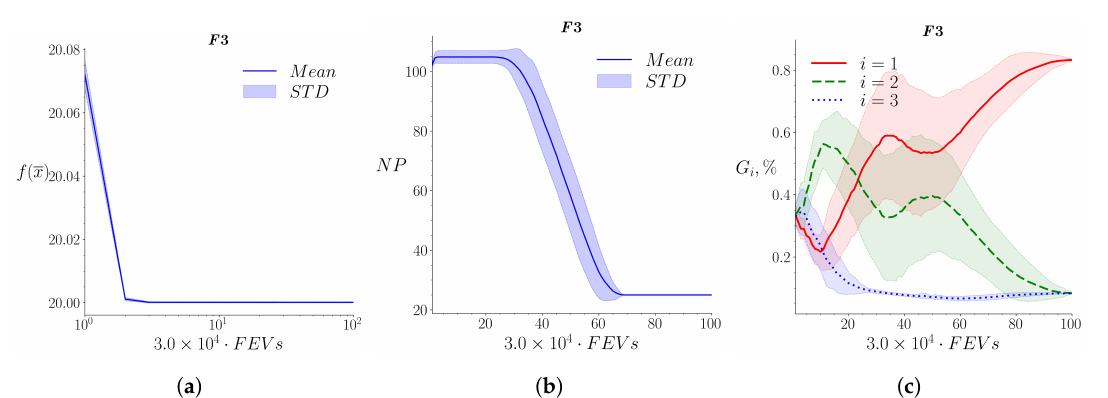
Figure A3. The dynamics of COSACC-LS1 on the F3 problem: ( a ) Convergence; ( b ) Population size;